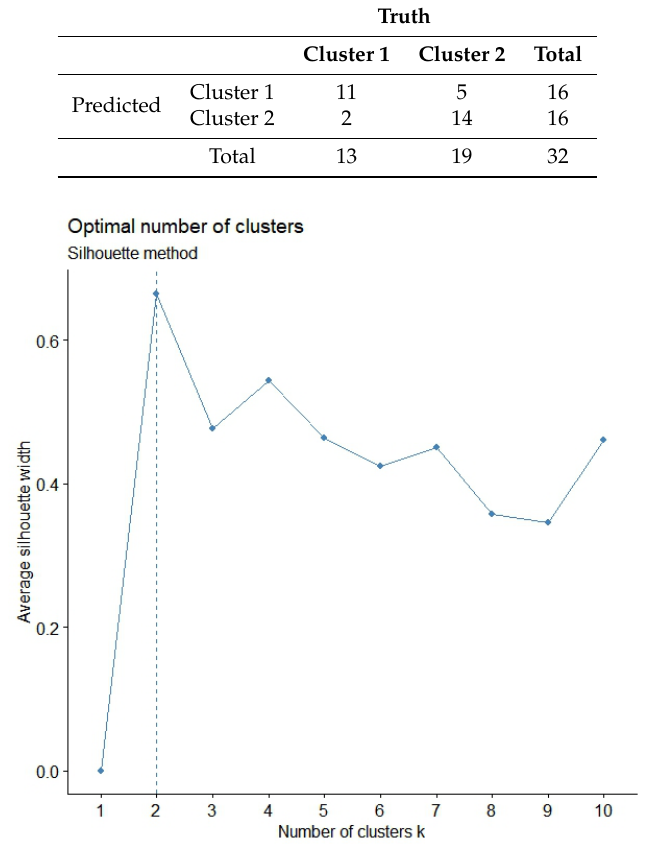
Figure 3. Plot of Silhouette Method showing the optimal number of clusters is